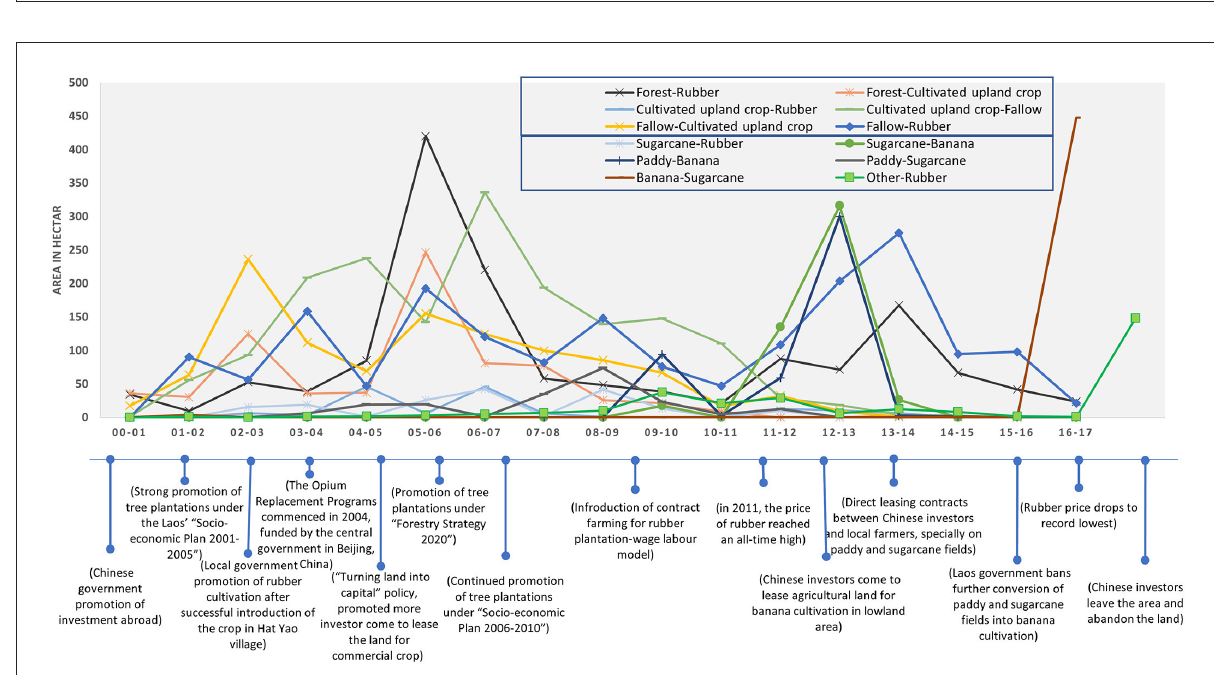
FIGURE4 From–to land use change from 1 year to the next between 2000 and 2017.